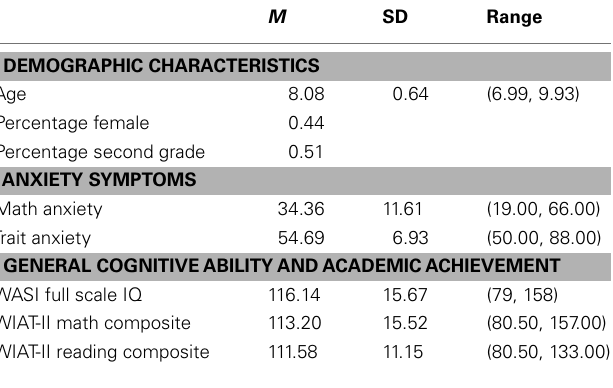
Table 1 | Descriptive characteristics of the